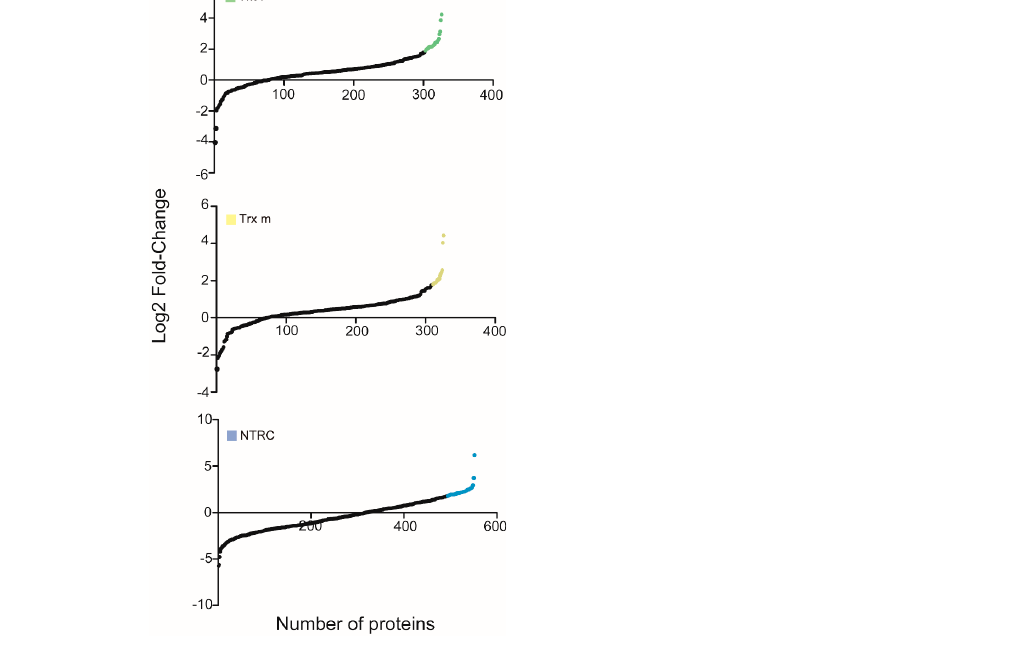
Figure 2. Proteomic analysis of the Trx-interacting proteins. Using quantitative mass spectrometry, eluted Trxs proteomes were compared to the control (empty-vector proteome). The candidate proteins are separately shown for Trx f (green), Trx m (yellow) and NTRC (blue).